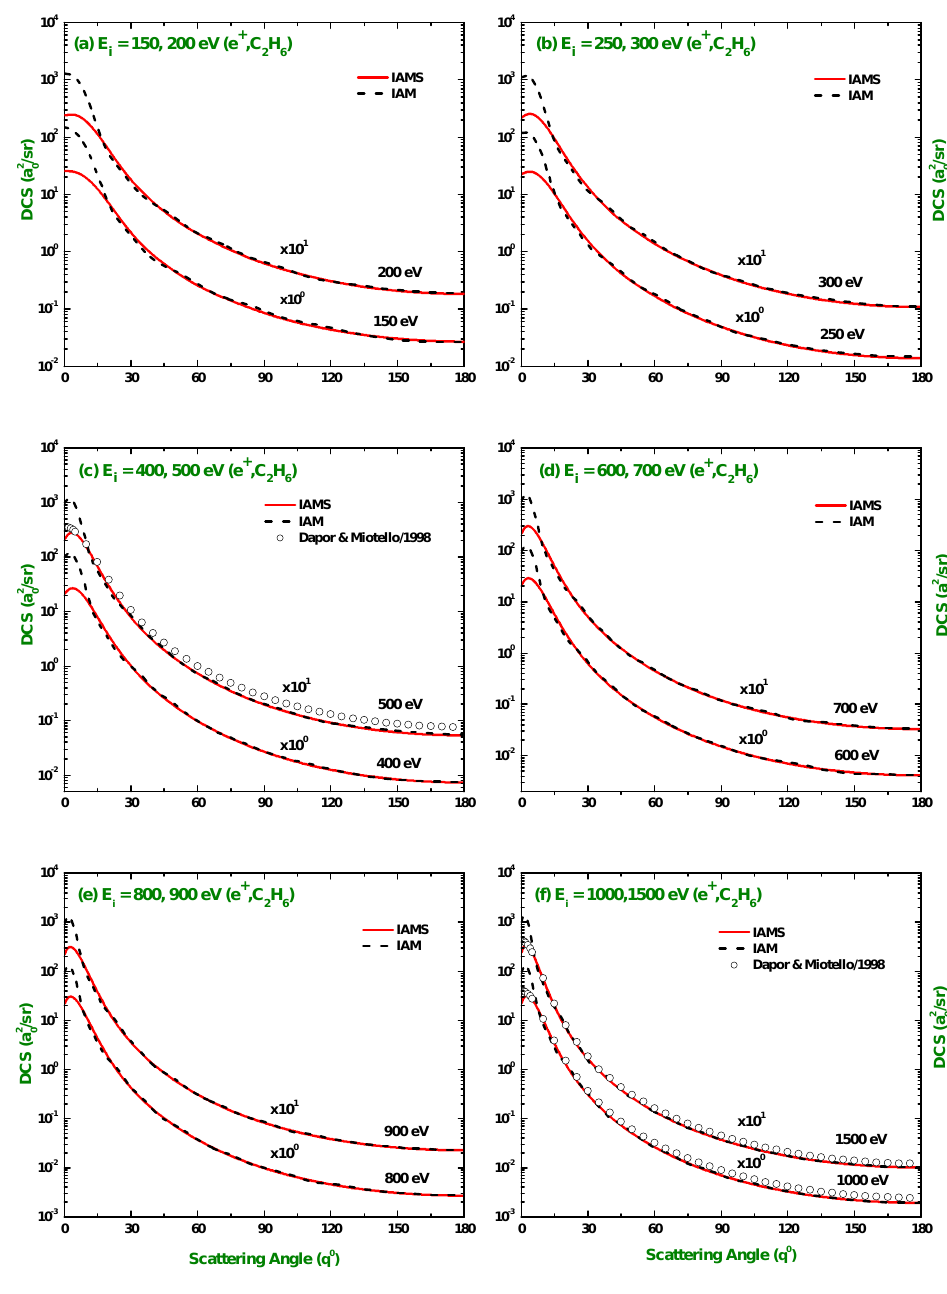
Figure 6. DCS ( a 2 / sr ) for the elastic scattering of positrons from C 2 H 6 at energies of 150 eV to 0 1500 eV. Theoretical works: References in Figure 5 and Dapor and Miotello